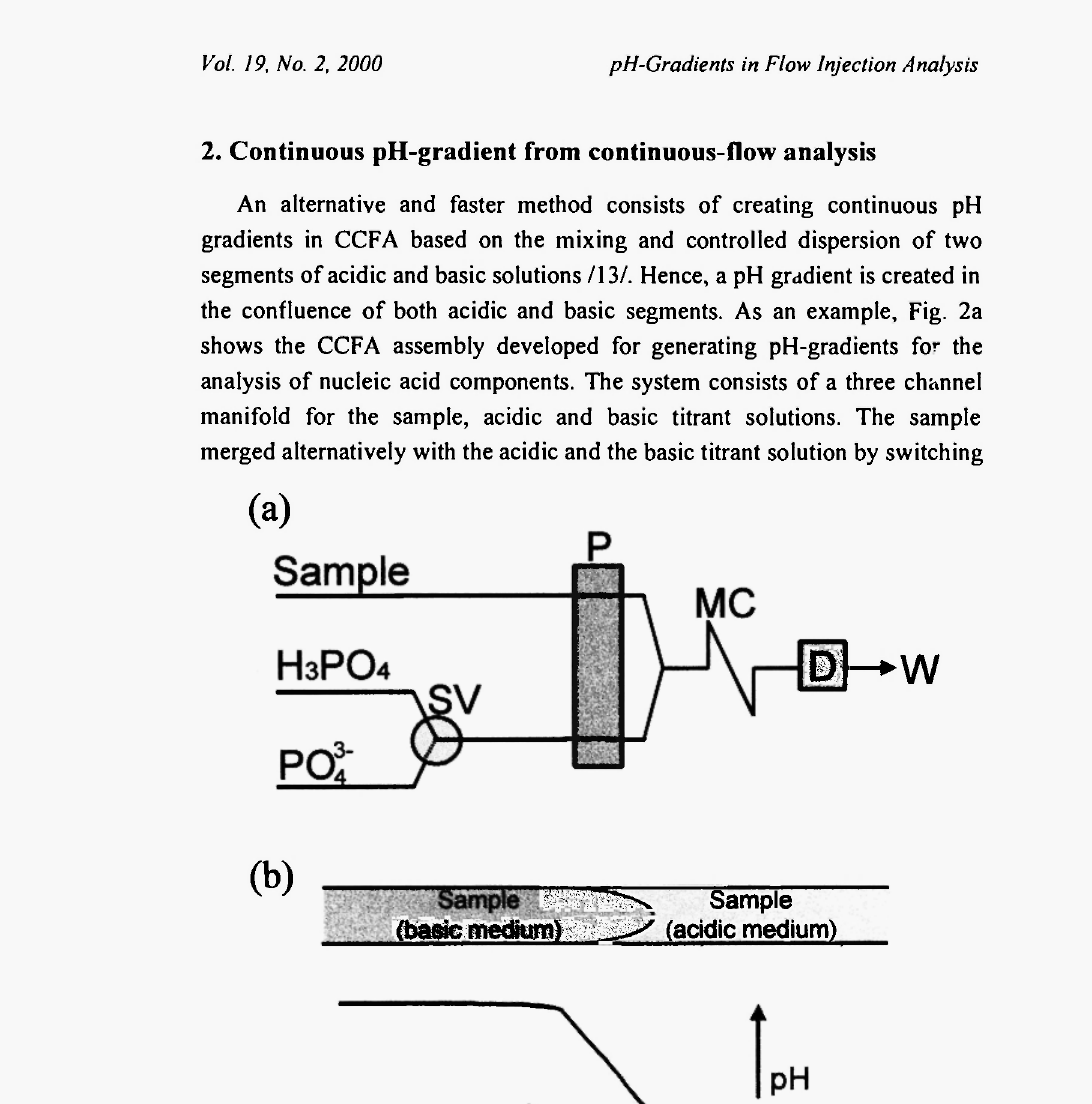
Fig. 2: Continuous flow system used for the generation of continuous pH gradients developed for the spectrophotometric determination of mixtures of nucleic acid components. (a) Scheme of the experimental assembly. Ρ = pump; SV = selection valve; MC = mixing coil (2 m χ 0.5 mm i.d.); D = diode array